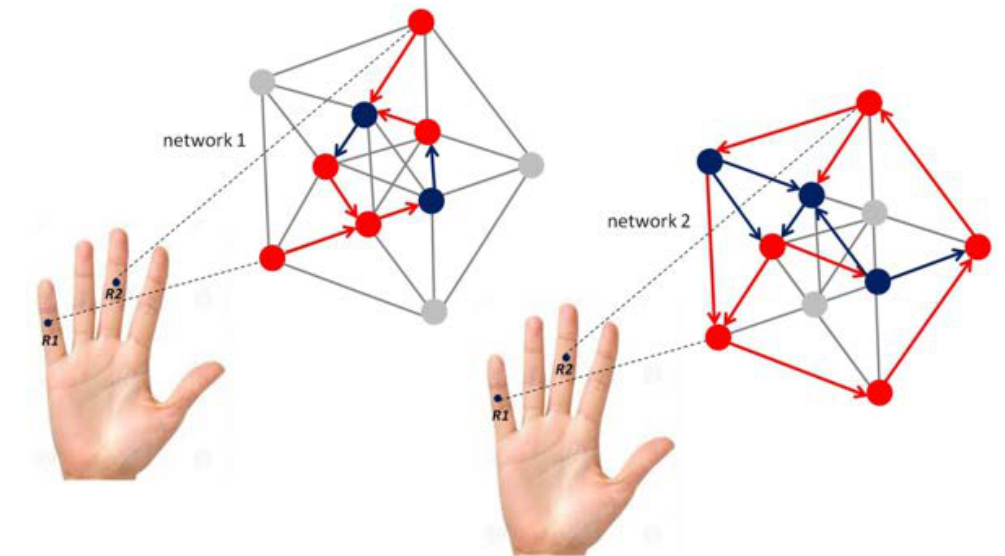
Figure 3. Schematic illustration of self-organizing functional reorganization in a fixed-size neural network in the somatosensory brain before (left) and after (right) unsupervised learning of a visually guided manual robotic precision task [103,104]. Mechanoreceptors on the middle phalanxes of the small (R1) and the middle fingers (R2) are indicated. Two di ff erent network representations correspond to brain-behaviour states before (left) and after acquisition of grip force expertise (right) for performing the robotic precision task. The di ff erent levels of connectivity used here are arbitrarily chosen, and for illustration only; single nodes in the networks displayed graphically here may correspond to single neurons, or to a subpopulation of neurons with the same functional role. Red nodes may represent motor cortex (M) neurons, blue nodes may represent connecting visual neurons (V). Only one-way propagation is shown here to keep the graphics simple, knowing that the somatosensory brain has multiple two-way propagation pathways with functional feed-back loops [82–85].